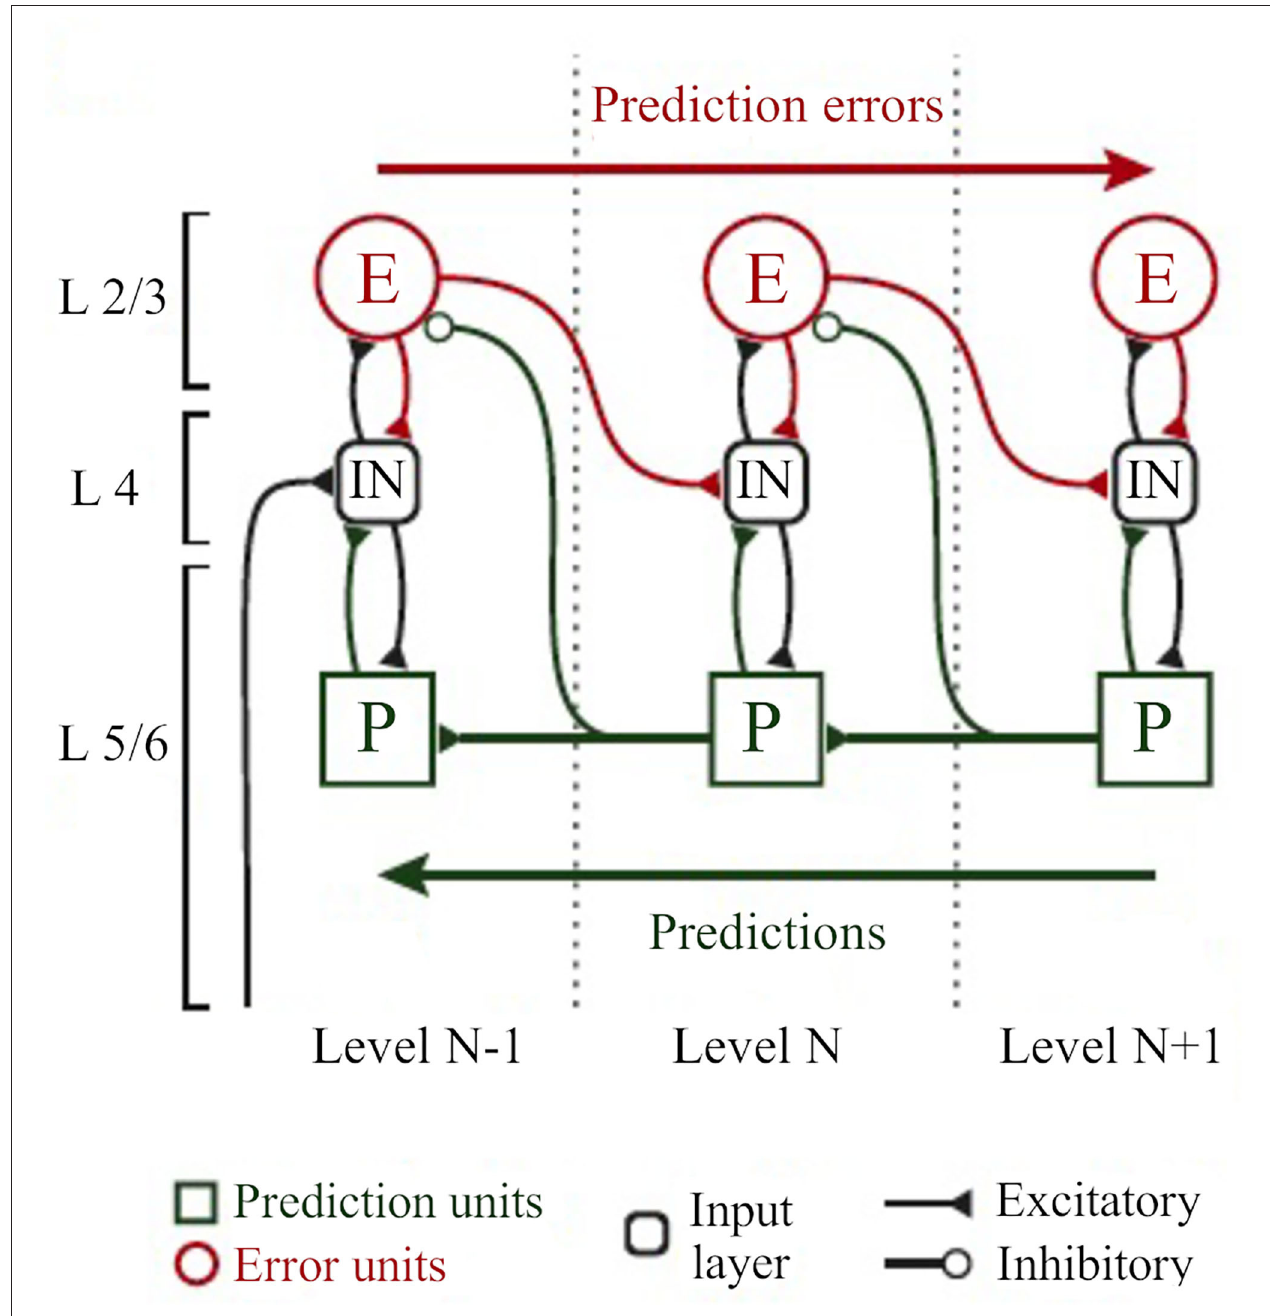
FIGURE 8 | The classical implementation of predictive coding relies on the cortical hierarchy. A simplified hierarchical model based on the classical implementation of predictive coding (Bastos et al., 2012). Vertical dashed lines delimit hierarchically arranged cortical columns (left to right: bottom up). Prediction errors climb up the cortical hierarchy through the feedforward, bottom-up connections, whereas predictions are sent backwards (top-down) to suppress prediction error units of the levels below, via inhibitory connections. Superficial layers (L2/3) above the subcortical input layer (L4) carry prediction errors, whereas deep cortical layers (L5/6) carry predictions. Adapted, with permission, from Heilbron and Chait (2018) and Carbajal and Malmierca (2020).